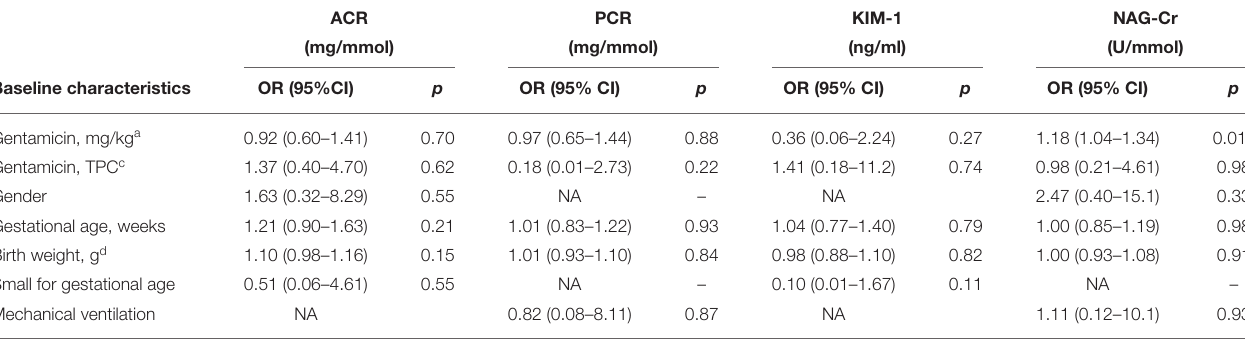
TABLE 4 | Univariate logistic regression of gentamicin exposure and other baseline characteristics assessed for the associated with abnormal urine biomarkers.